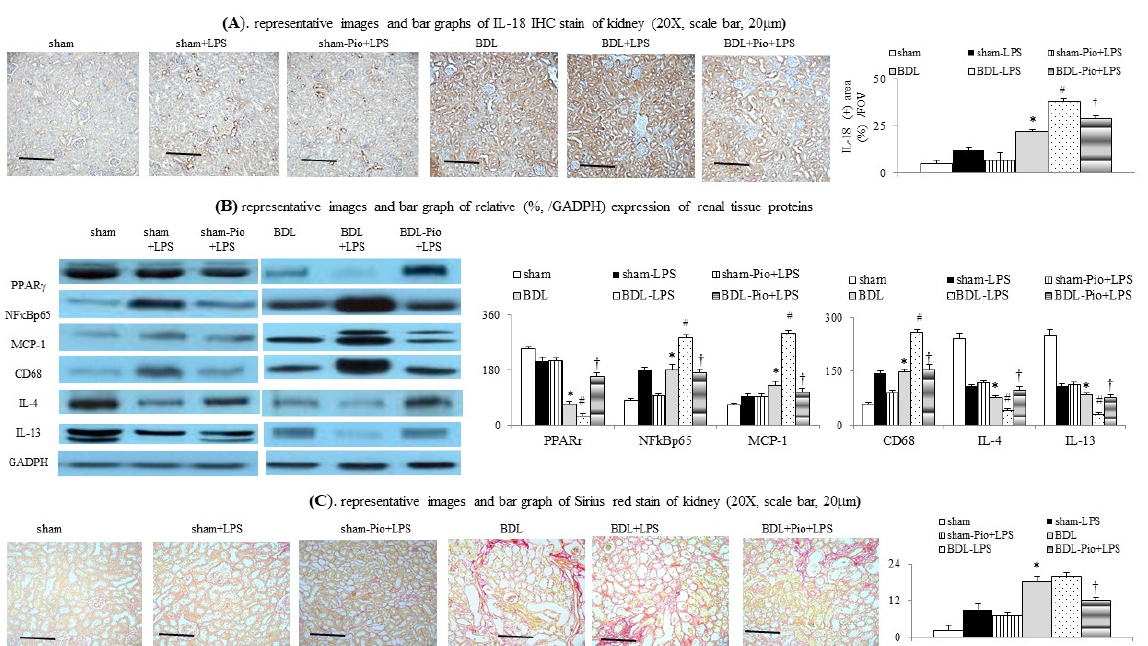
Figure 2. Chronic pioglitazone treatment suppressed LPS-induced acute on chronic renal dysfunction by prevention of increased renal macrophage infiltration. ( A ) Renal interleukin-18 (IL-18) expression; ( B ) various renal protein expressions between groups; ( C ) renal Sirius Red staining expression; * p < 0.05 vs. sham group; # p < 0.05 vs. BDL group; † p < 0.05 vs.